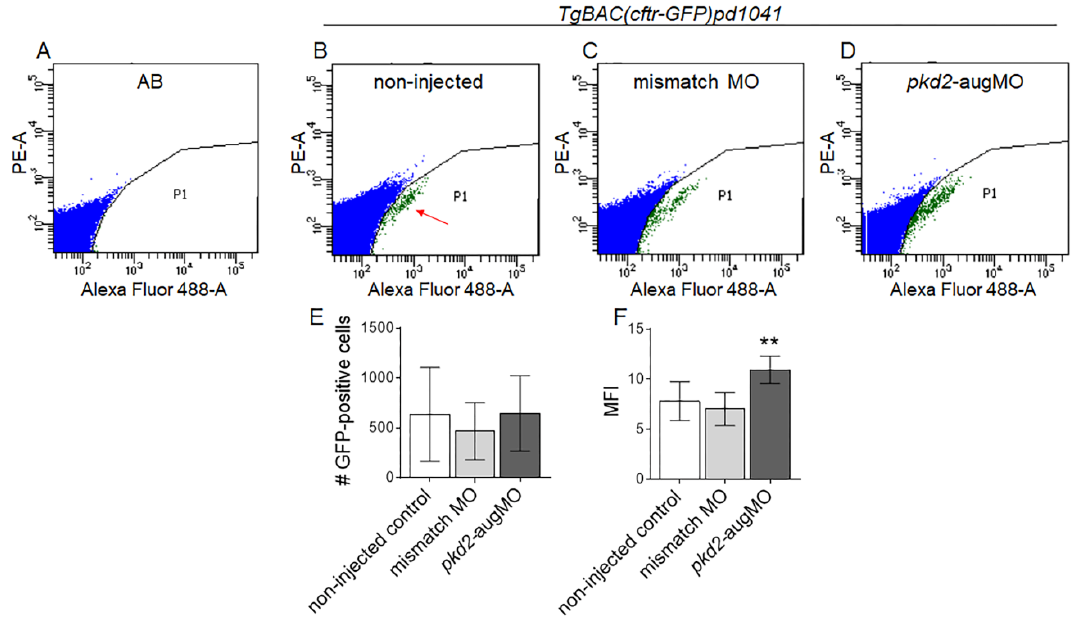
Figure 4. Flow cytometry analysis of the CFTR-GFP protein level in TgBAC(cftr-GFP)pd1041 embryos. Flow cytometry plots representative of AB control ( A ) and non-injected TgBAC(cftr-GFP)pd1041 8–10 ss ( B ) embryos, for the established limiting gates. Red arrow indicates the GFP-positive cell population. ( C , D ) Flow cytometry plots representative of the GFP-positive cells of mismatch-MO ( C ) and pkd2 -augMO ( D ) embryos. ( E ) Number of analyzed GFP-positive cells of non-injected controls (11 replicates), mismatch-MO (3 replicates), and pkd2 -knockdown embryos (5 replicates). Each replicate had about 200 embryos. ( F ) MFI determined for GFP-positive cells of non-injected controls, mismatch-MO, and pkd2 -knockdown embryos. Median averages ± SD are indicated. As the pkd2 -augMO injected embryos sample did not follow a normal distribution, the Mann–Whitney test was used to compare pkd2 -augMO versus non-injected embryos MFIs, ** p < 0.01.